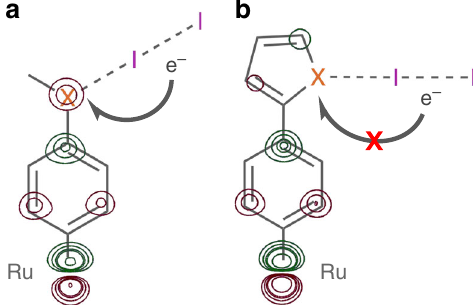
Fig. 4 Orbital pathway for IET. A schematic depicting the electron transfer pathway between diiodide X-Me a or X-Ar b , through the iodide···chalcogen interaction. The Ru complex fragment is overlaid with a contour plot of the β -LUMO down to an iso-value of